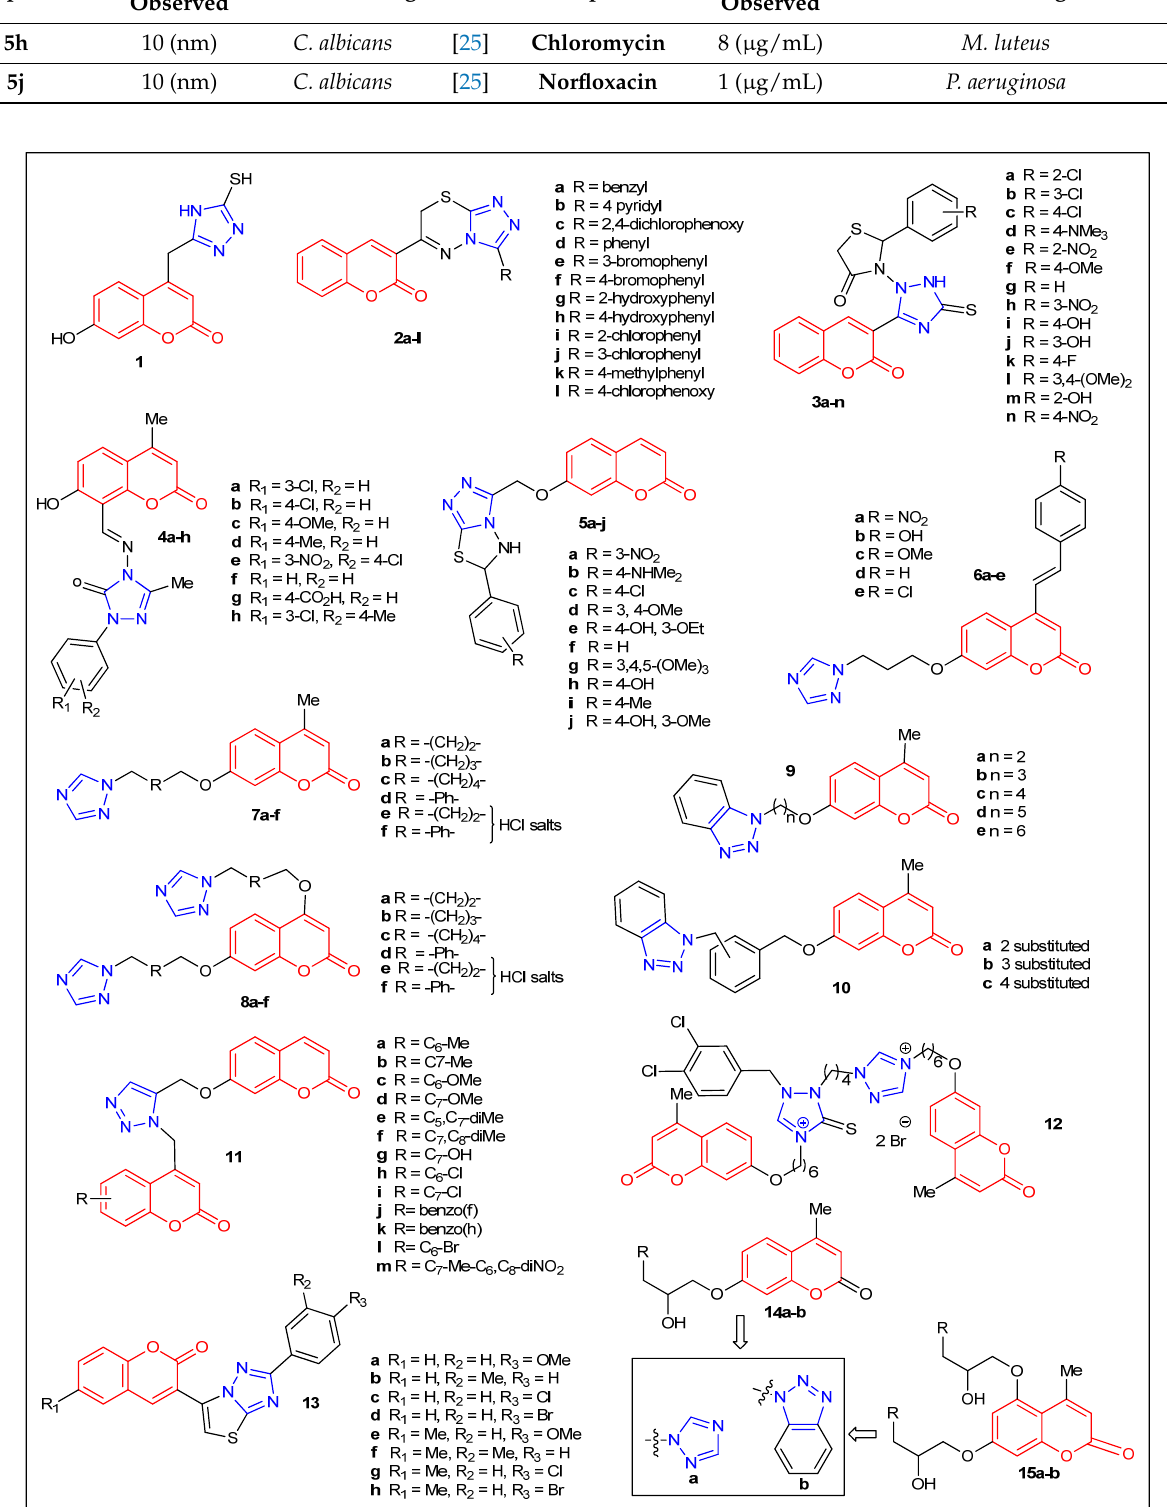
Figure 3. Structures of the reported coumarin triazole derivatives from 2006 – 2014 .